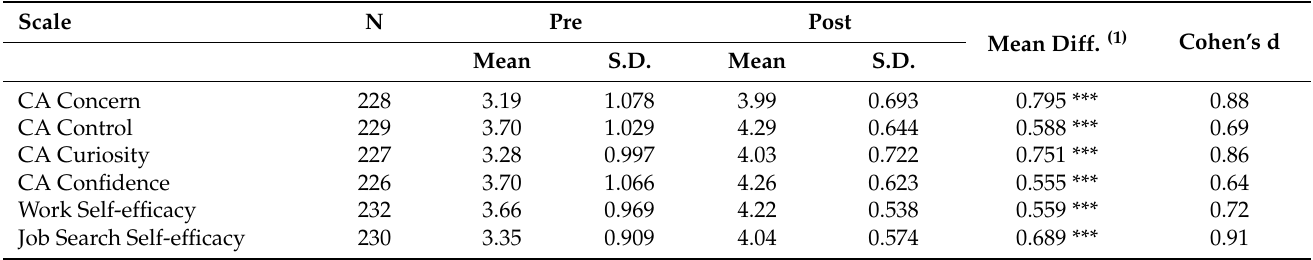
Table 3. Statistic significance and effect size of the differences between post- and